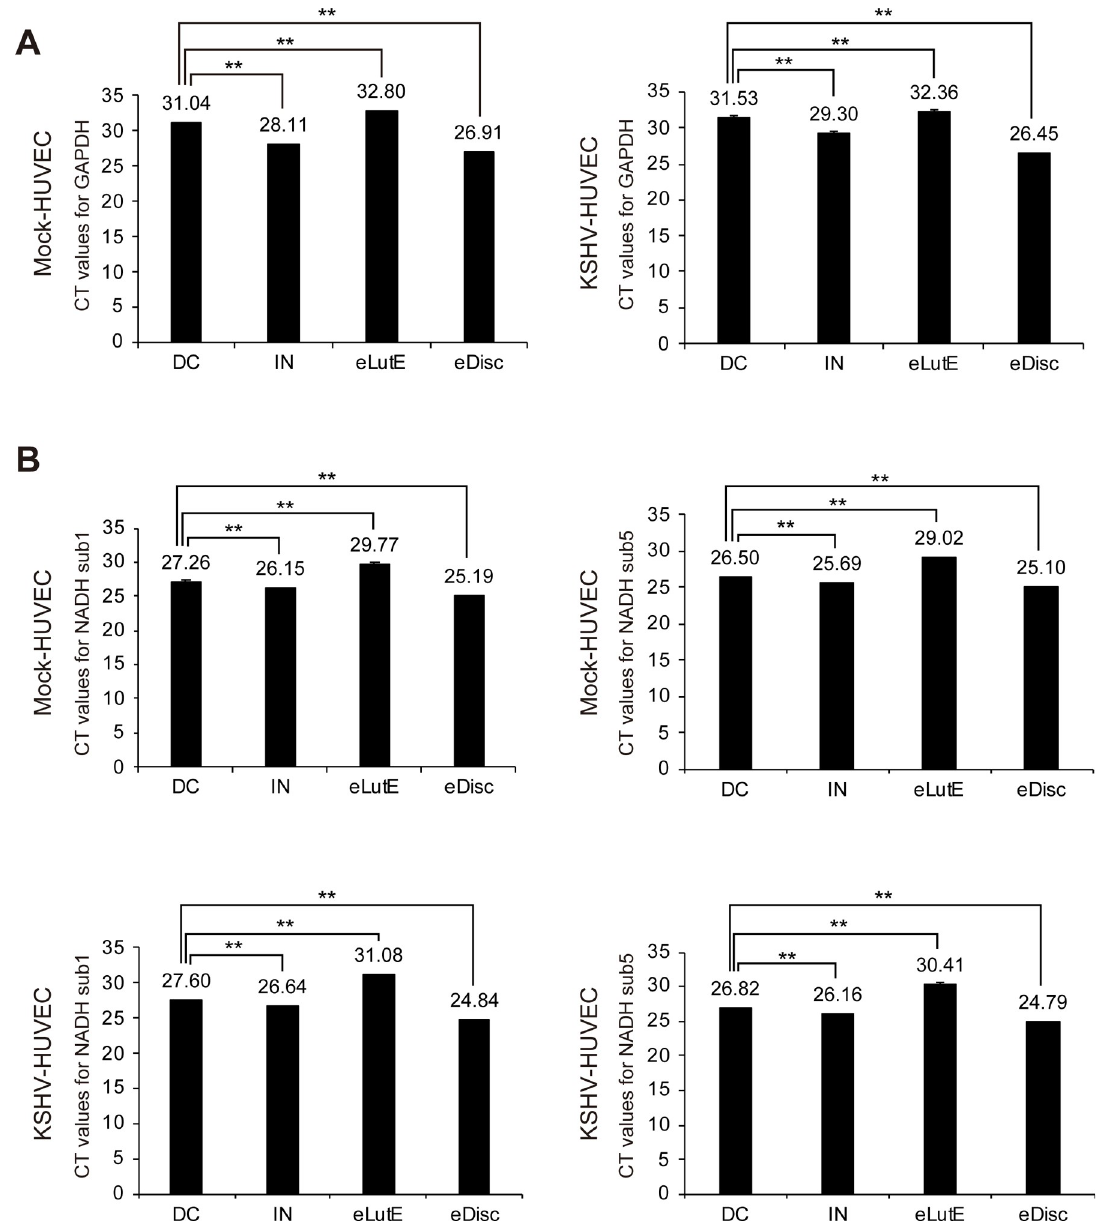
Fig 4. Analysis of DNA from EVs separated using each method. EVs were separated from the supernatants of non-infected or KSHV- infected HUVECs using the four different EV separation methods. Equal volumes of DNA extracted from the EVs separated by each method were analyzed with qRT-PCR. qRT-PCR was used to analyze genomic and mitochondrial DNA for GAPDH (A) and NADH subunits 1 and 5 (B), respectively. The number above the bar graph indicates the average CT value from the qRT-PCR reaction. CT values from differential centrifugation were used as a control. DC: EVs separated using differential centrifugation. IN: EVs separated using the Invitrogen Total Exosome Isolation reagent. eLutE: EVs separated using the ExoLutE exosome isolation kit. eDisc: EVs separated using Exodisc from LabSpinner. Mock-HUVEC: mock-infected HUVECs. KSHV-HUVEC: KSHV-infected HUVECs. Data are shown as the mean ± SD, n = 3, �� p < 0.01. protein found in the EVs from KSHV-infected HUVECs than in EVs from non-infected HUVECs, the pattern of protein quantity extracted from EVs using each method was similar between the EVs from the non-infected and KSHV-infected cells.